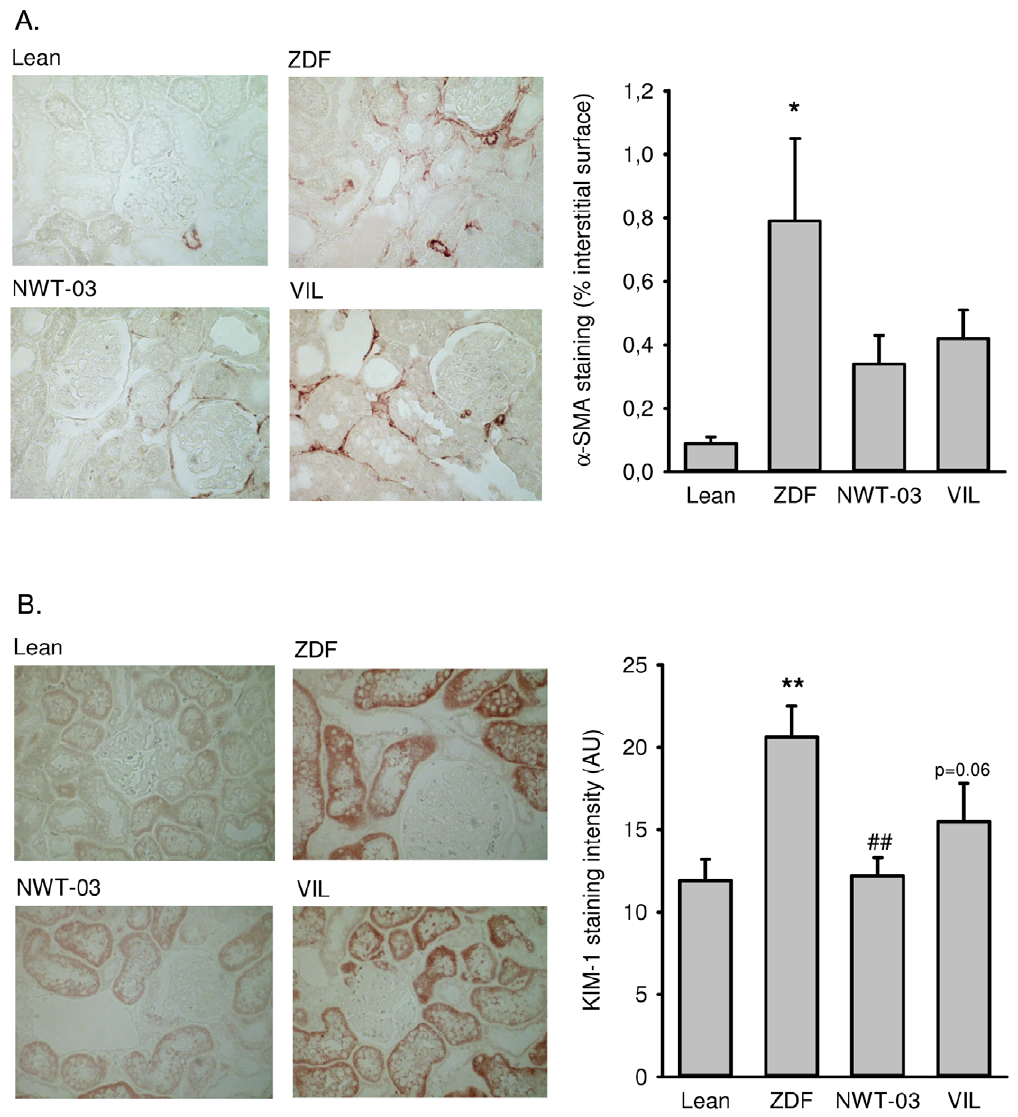
Figure 1. Renal expression of (A) a -SMA and (B) KIM-1. Shown are representative pictures of lean control rats (top left) and untreated ZDF rats (top right), and ZDF rats supplemented with NWT-03 (bottom left) or treated with VIL (bottom right). Bars in the graphs represent the average per group, presented as means 6 SEMs (*p , 0.05 and **p , 0.01 vs lean; ## p , 0.01 vs ZDF).